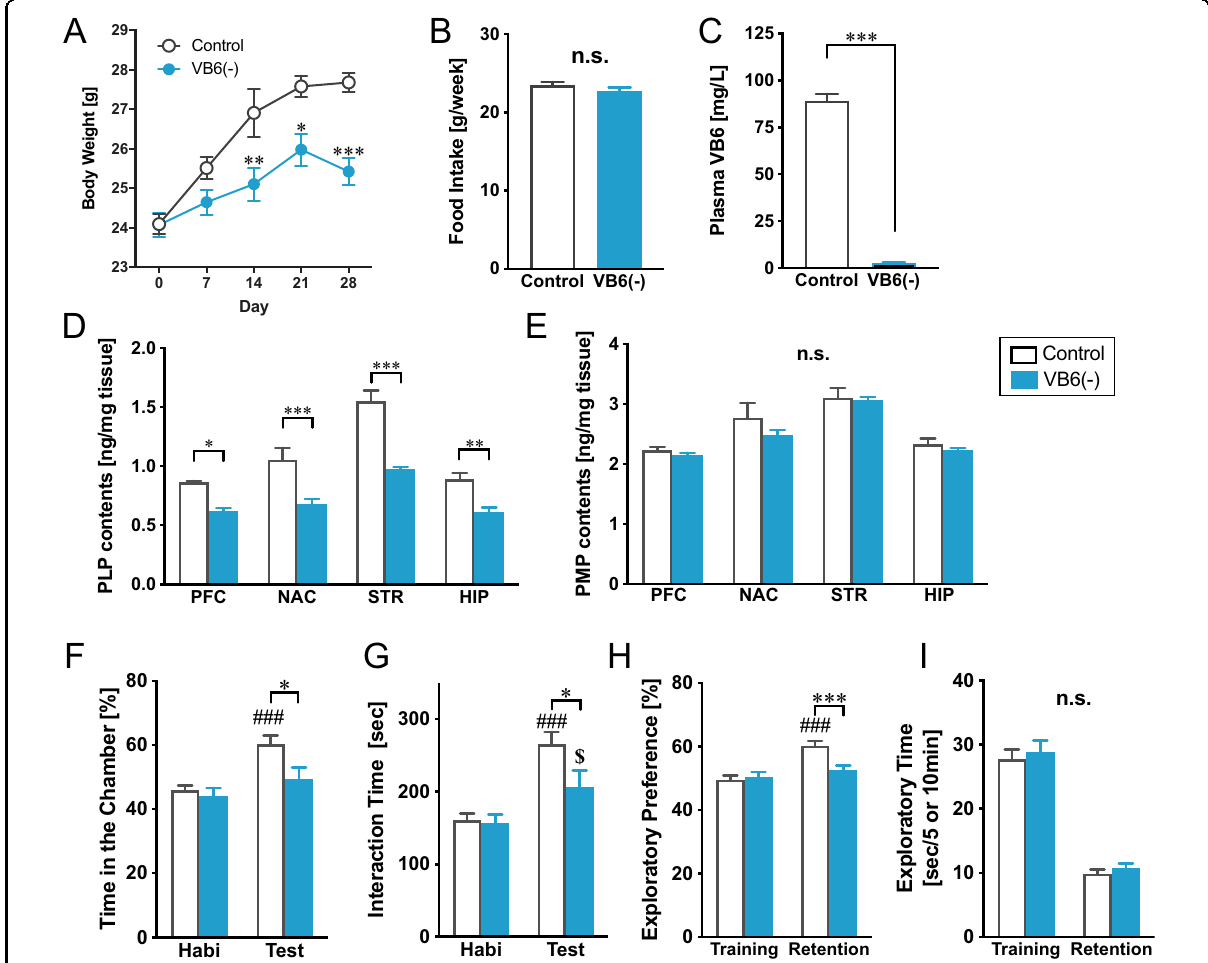
Fig. 1 Generation of VB6-de fi cient mouse model and their behavioral abnormalities. VB6( − ) mice were generated by feeding with a VB6- lacking diet from 8 to 12 weeks of age. A Changes in body weight during feeding with a VB6-lacking diet are shown. Two-way ANOVA with repeated measurements: